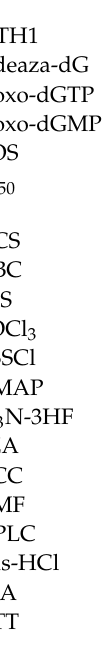
ADME parameter of compound 9 , Figure S2: Predicted ADME parameter of compound 10 , Figure S3: Predicted ADME parameter of compound 11 , Figure S4: Predicted ADME parameter of compound 12